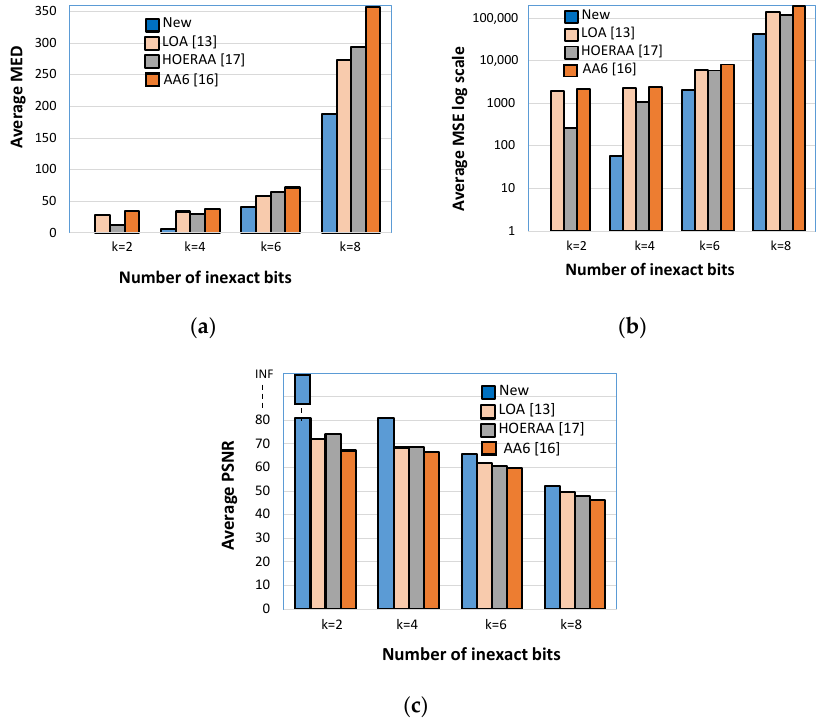
Figure 11. Accuracy results obtained for the Peppers benchmark in terms of: ( a ) MED; ( b ) MSE; ( c ) PSNR.